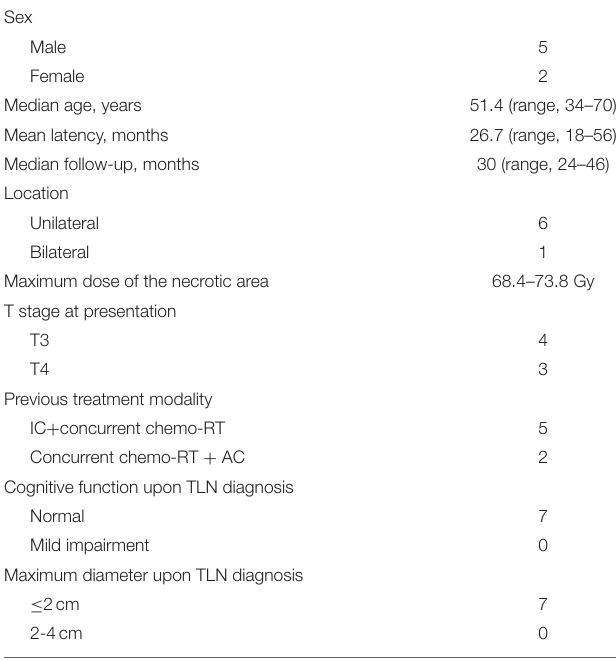
TABLE 2 | Details of the 7 patients with spontaneous remissions of TLN.